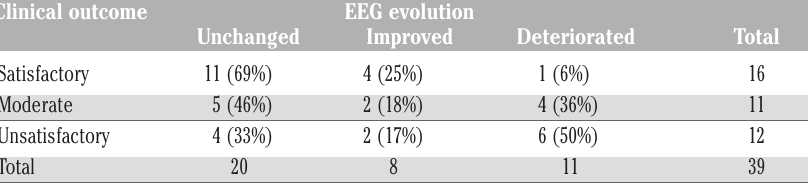
Table 3. Clinical outcomes in relation to the electroencephalography evolution.